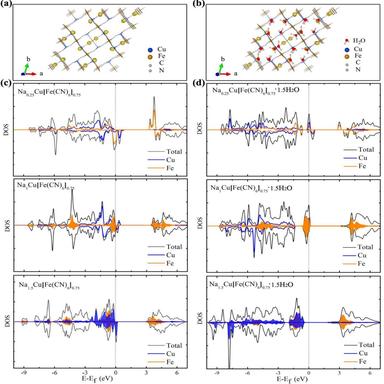
The standard structure of (a) dehydrate Na2Cu0.75, and (b) hydrate Na2Cu0.75‧1•5H2O for first-principles studies. Electronic density of states of (c) dehydrates and (d) hydrate CuHCF at different Na concentrations, including Na-0.25, Na-1, and Na-1.5.